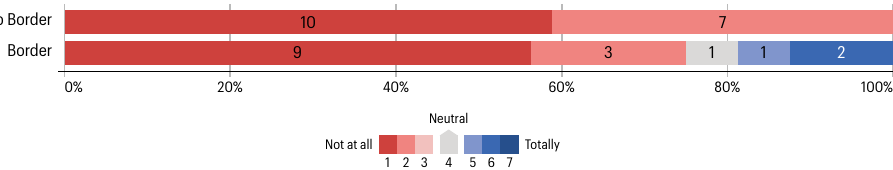
Figure 6. Ratings of disturbance in the No Border or Border conditions. Participants found the lack of virtual borders not disturbing, but more of them were disturbed by their presence in the Border